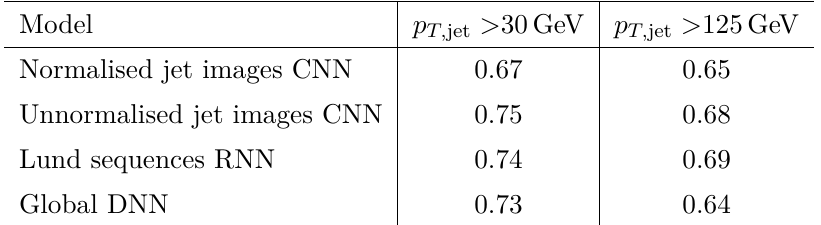
Figure 10 . ROC curve for the separation of the Vacuum and Medium samples using the different Deep Neural Network models.